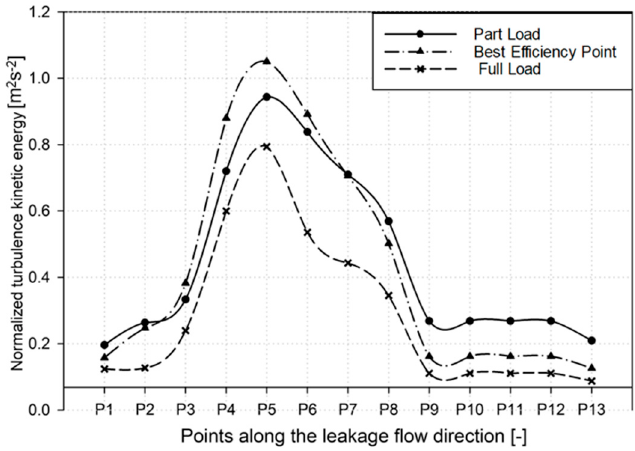
Figure 10. Turbulence kinetic energy variation along the LV trajectory.